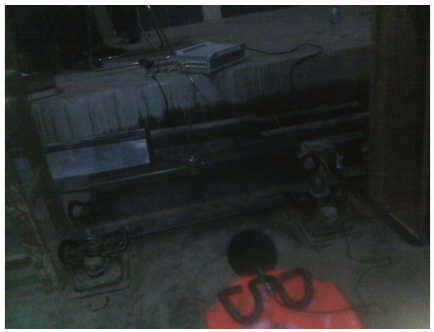
Figure 17: Laboratory vibroacoustic